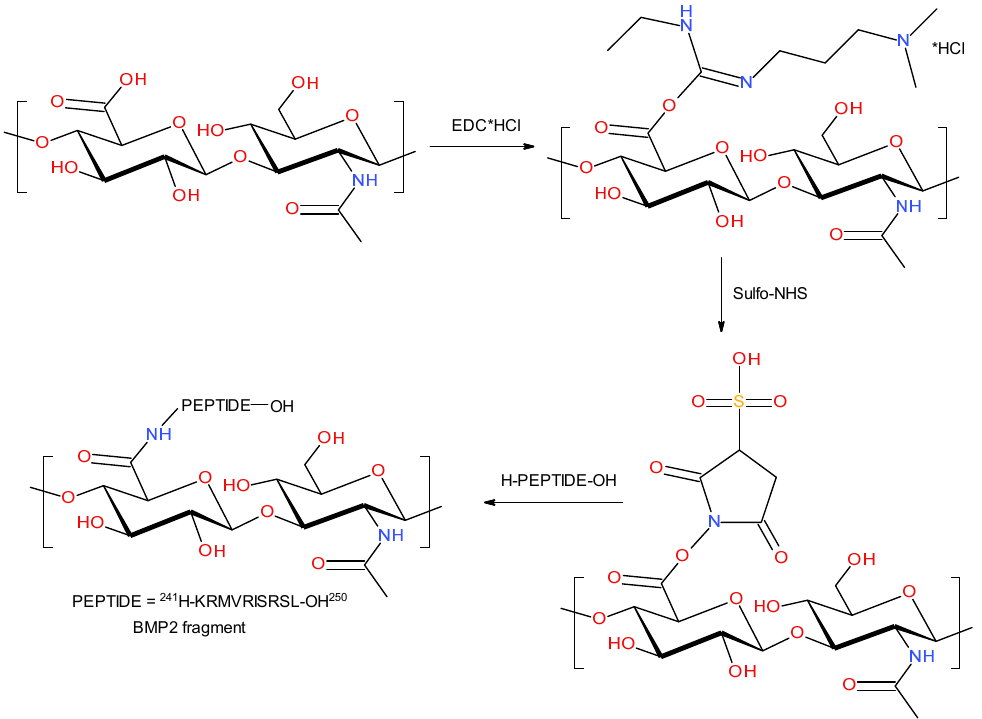
Figure 16. Schematic reaction of the condensation of carboxyl groups of polysaccharides with amino groups of H-KRMVRISRSL-OH by using EDC/NHS .